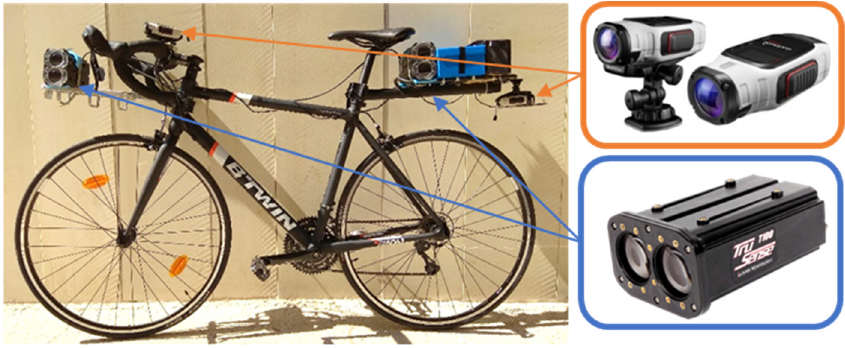
Figure 3. Instrumented bicycle equipped by cameras and a laser